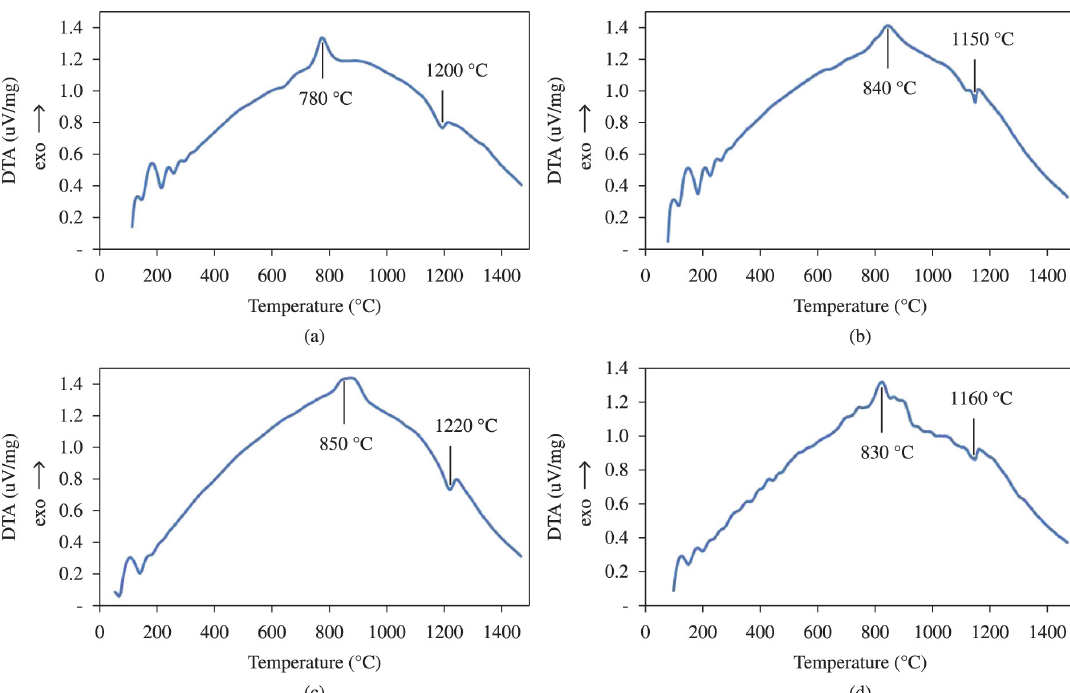
Figure 5. Differential thermal analysis of rock wools fabricated using only granite waste (a), only steelmaking slag (b), both residues (c), and from a industrial sample